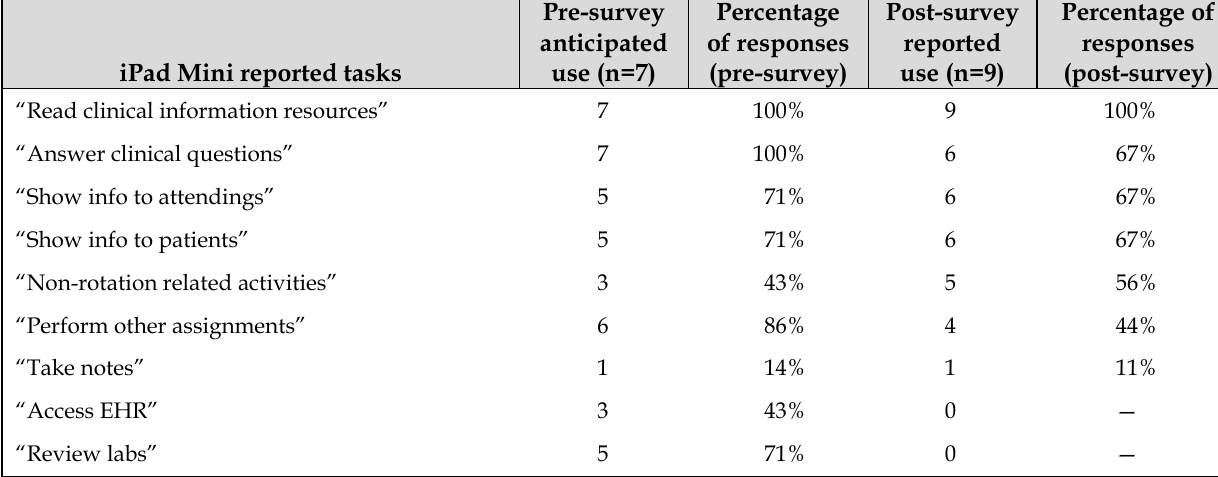
Table 3 iPad Mini reported tasks